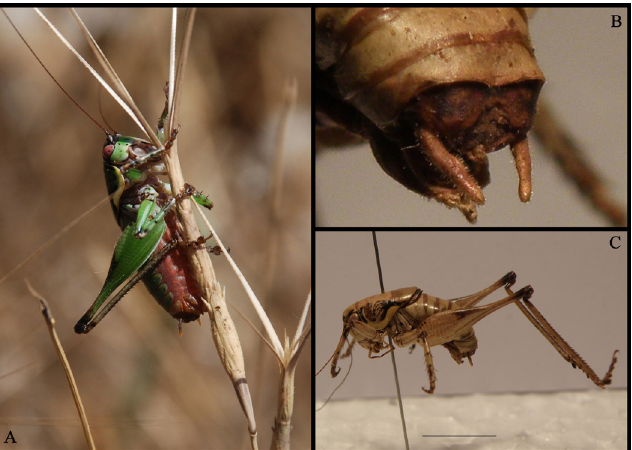
Figure 5. Eupholidoptera kykladica , Attiki, Vravrona, 11 VI 2013. A . habitus, B . last abdominal segment, dorso-lateral view, C. lateral view (scale bar: 1 cm).